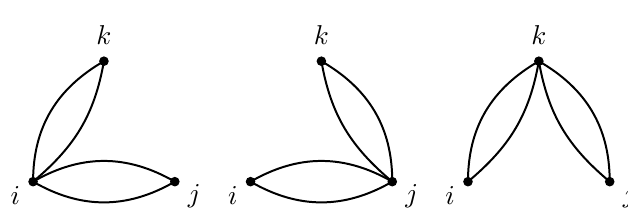
Figure 5 . Graph representation of another class of contributions of the correlator of four twist operators to I 4 when the twist operators have non-trivial support on three